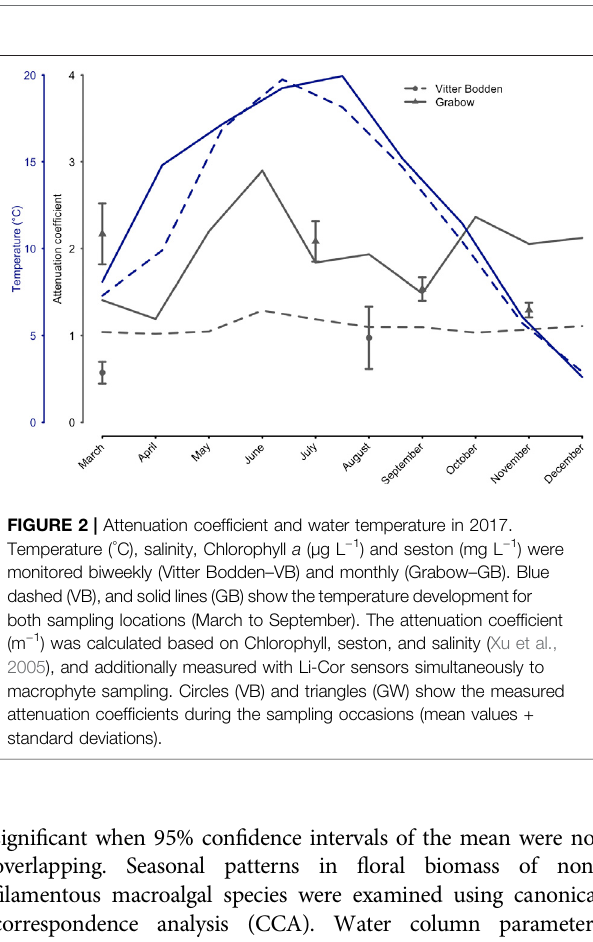
Frontiers in Earth Science |